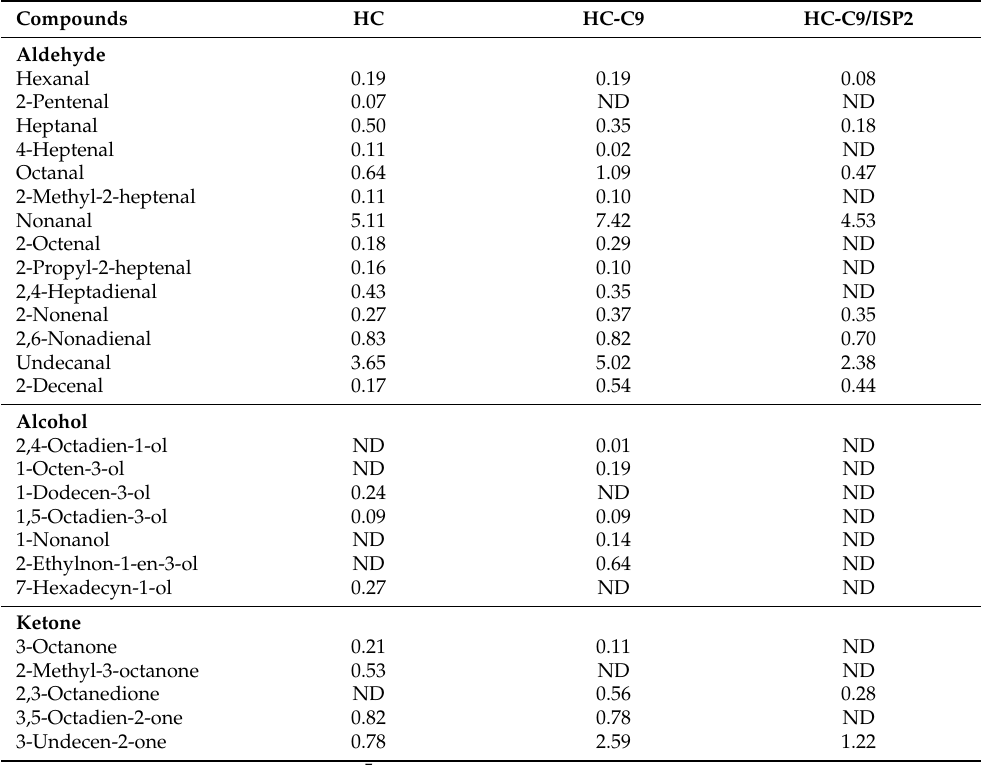
Table 6. Volatile compounds of hydrolyzed collagen without and with different fat removal processes. Compounds HC HC-C9 HC-C9/ISP2 Aldehyde Hexanal